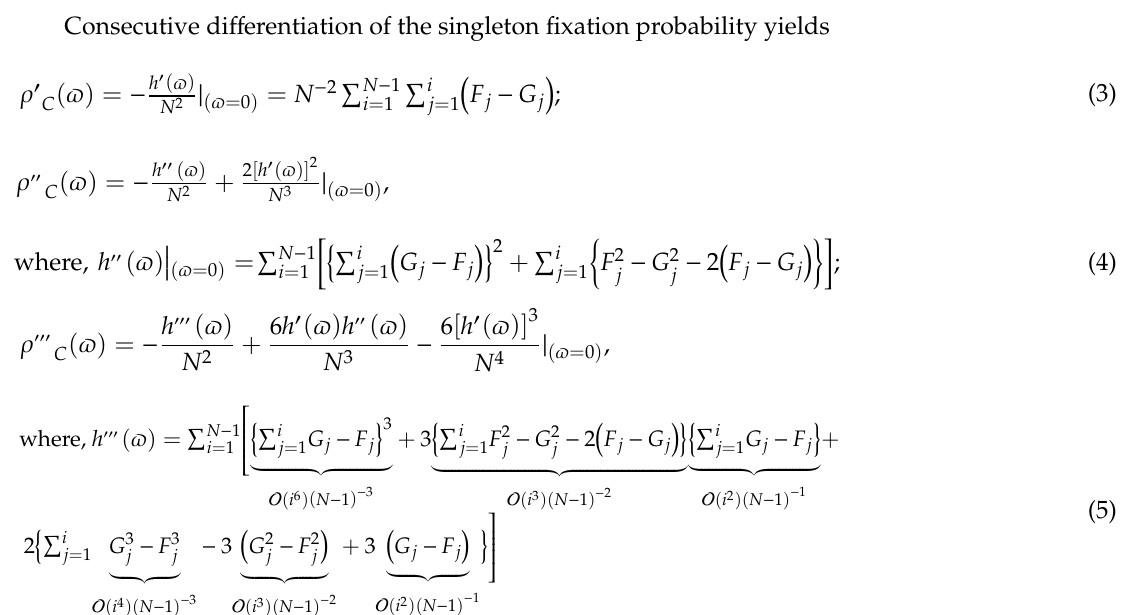
(cid:48)(cid:48)(cid:48) ( (cid:36) ) from Equation (5) obtains via orders C